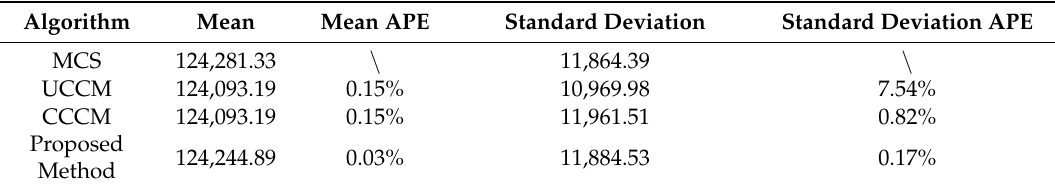
Table 9. Comparison of generation cost (modified IEEE 118-bus test